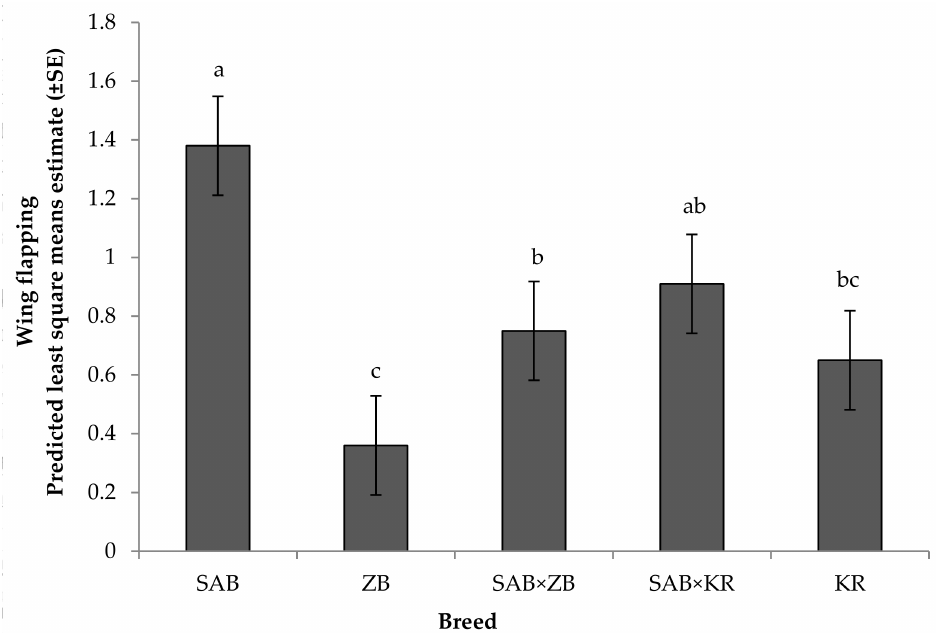
Figure 6. Means depicting the effect of breed on wing flapping by ostriches in the reactivity tests that approached the handler ( N = 207). SAB: South African Black ( N = 160); ZB: Zimbabwean Blue ( N = 5); KR: Kenyan Redneck ( N = 4); and their cross-bred combinations: SAB × ZB ( N = 19) and SAB × KR ( N = 19). Means with different superscripts differed significantly ( p <